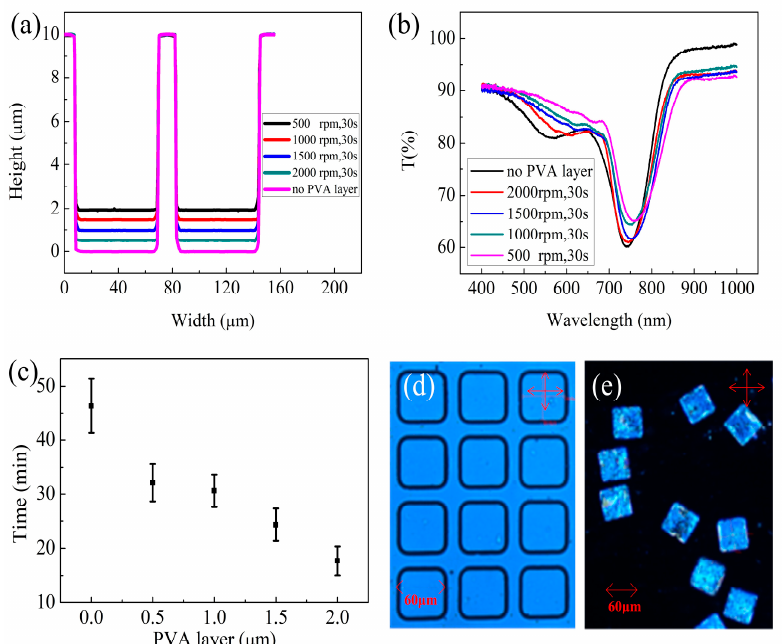
Figure 6. Influence of the PVA layer thickness on the reflectance and release time of the PCLC flakes from the 60 μ m × 60 μ m size PDMS mold: ( a ) Surface profiles of the PDMS mold after spin-coating PVA at different speeds; ( b ) transmittance of PCLC flakes with different thicknesses; ( c ) The release times of different thicknesses of PVA layers; ( d ) the POM image of the PDMS mold after flakes were released; ( e ) the POM image of the released PCLC flakes.